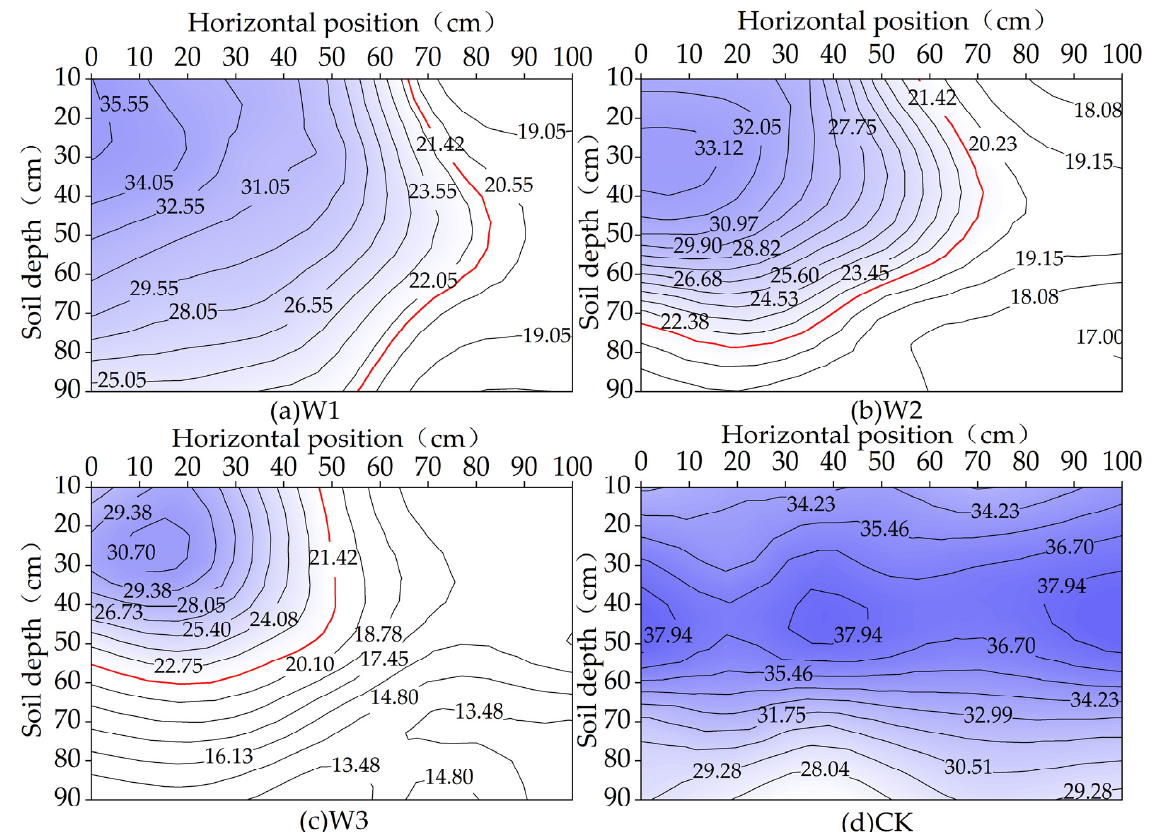
Figure 4. Spatial distribution of soil moisture under different irrigation treatments. The red dash line means soil moisture threshold, 65% of the average field water holding capacity of the 0–100 cm soil layer. W1, W2, and W3 indicate irrigation amounts of 880, 660, and 440 mm under drip irrigation, CK indicates irrigation amount of 1100 mm under flood irrigation. The sampling date was 23 July 2018, after 24 h of one irrigation event.